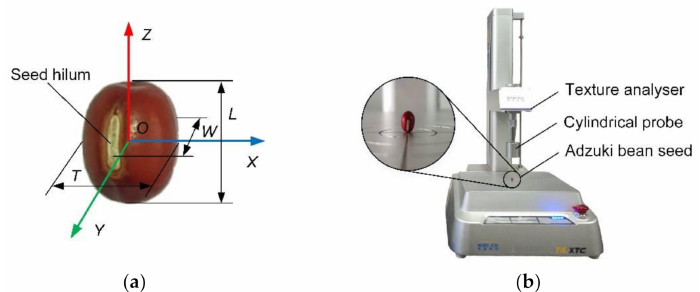
Figure 1. Intrinsic parameter measurement. ( a ) triaxial size measurement position; ( b ) compression test.